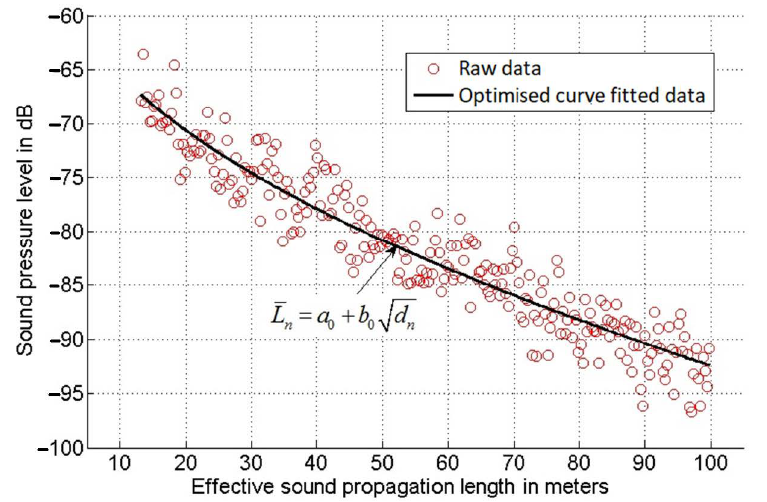
Figure 3. Example of the curve fitting